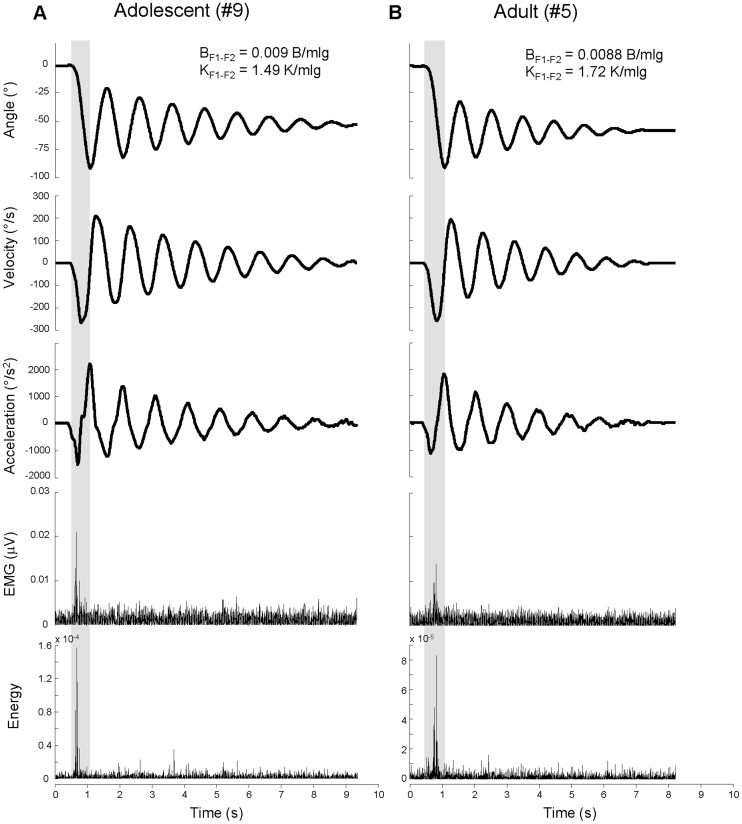
Examples of kinematic and EMG traces.Kinematic and EMG traces recorded in one adolescent (A) and one adult (B) with Down syndrome. Shadow areas highlight the excursion of the first flexion. BF1-F2 and KF1-F2 are normalized damping and stiffness coefficients for the first extension-flexion cycle after the first fall. The last two rows represent the full wave rectified EMG without (fourth row) and with (fifth row) TKEO signal condition.